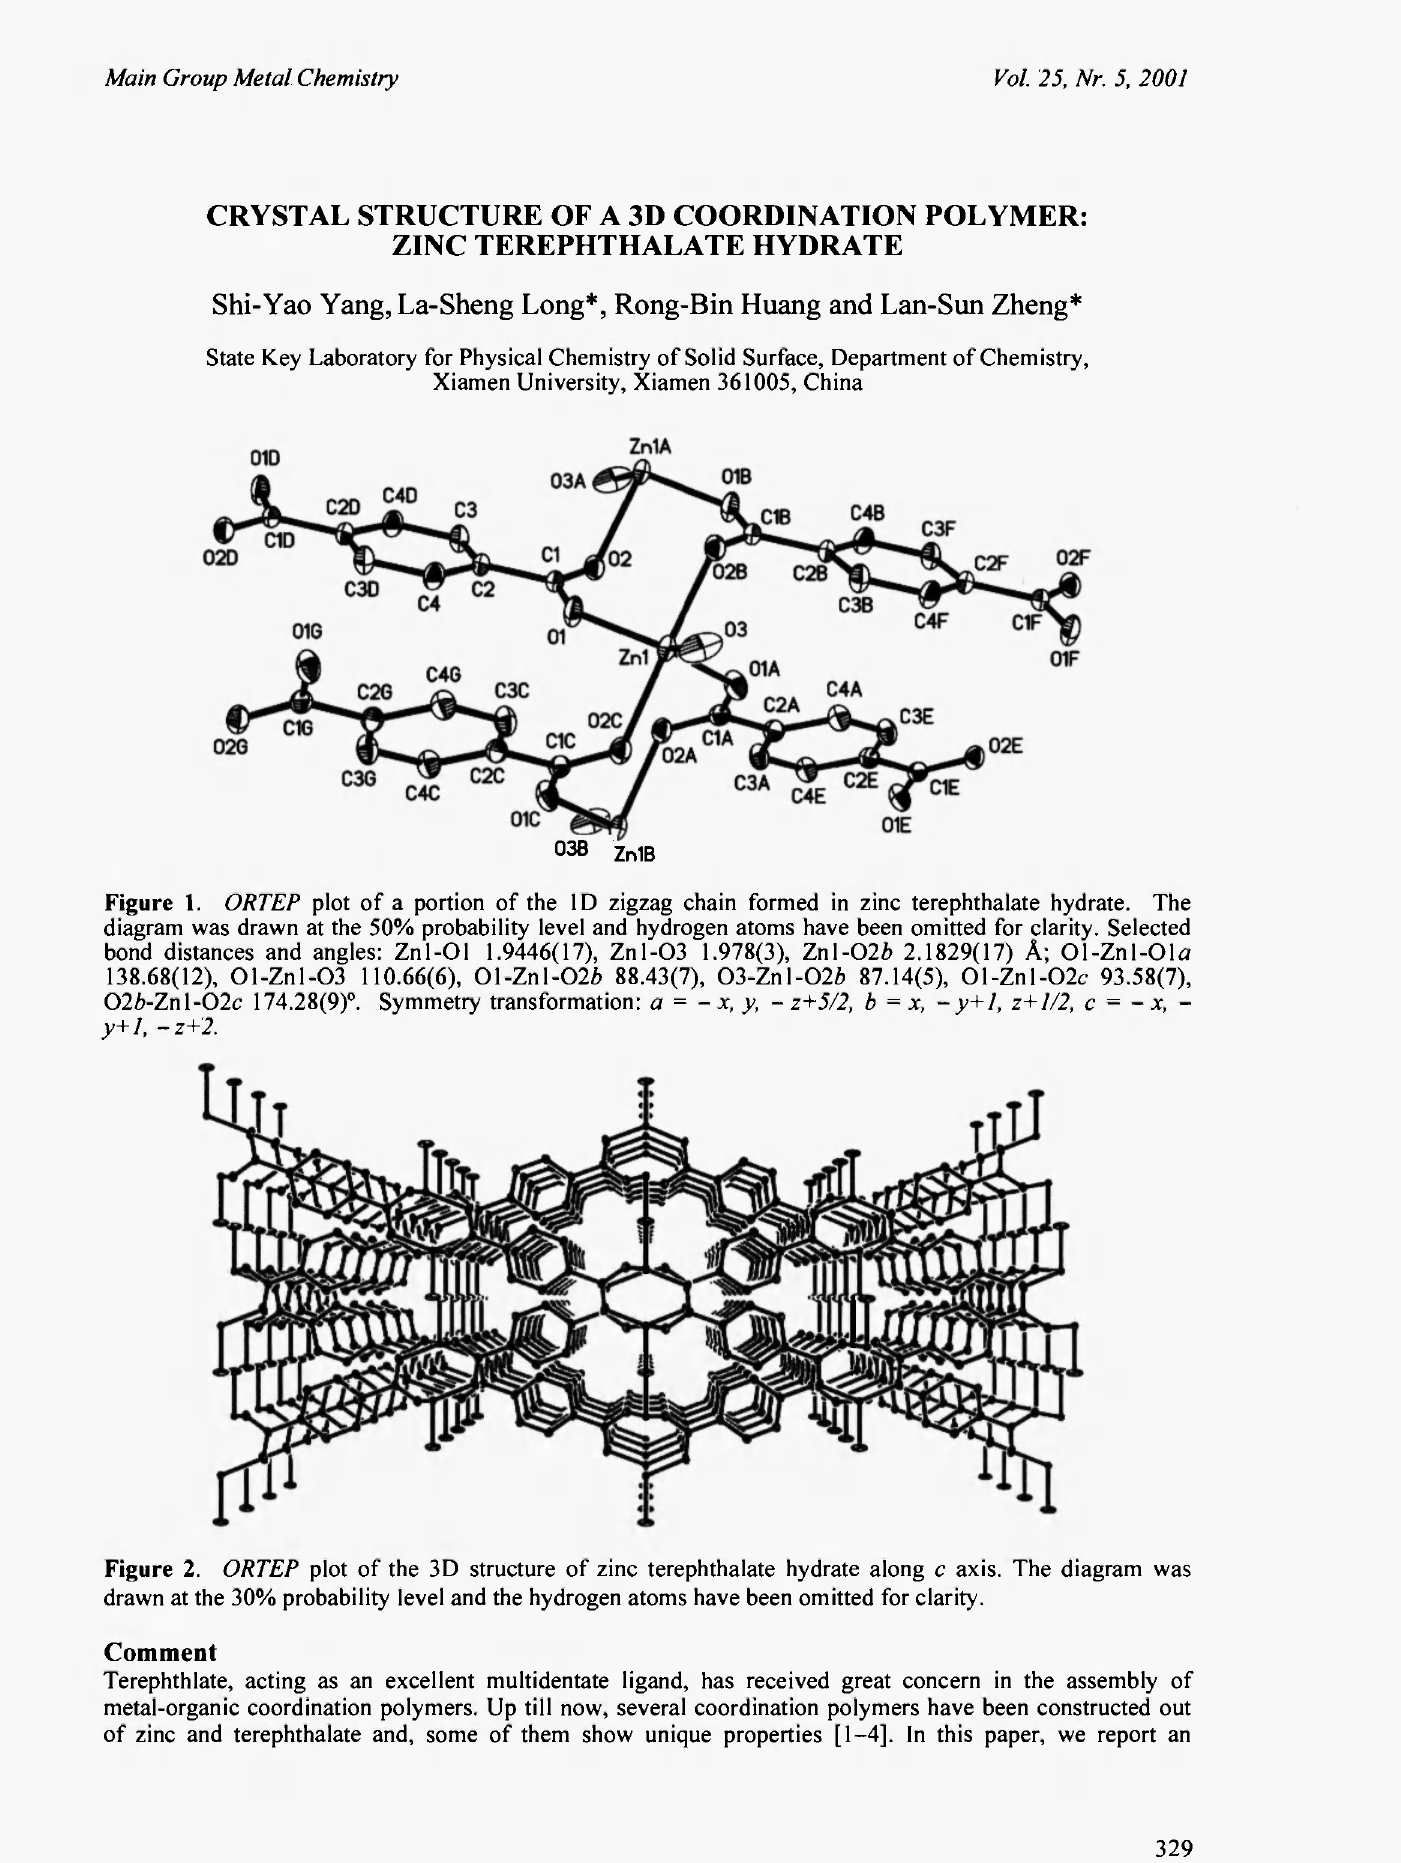
Figure 2. ORTEP plot of the 3D structure of zinc terephthalate hydrate along c axis. The diagram was drawn at the 30% probability level and the hydrogen atoms have been omitted for